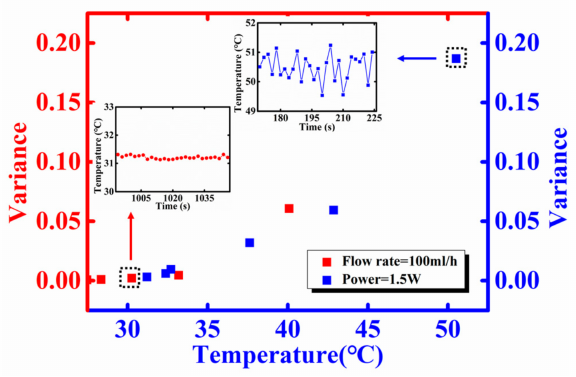
Figure 10. The variance of temperature fluctuation with the temperature change of the micro fluid by changing the power on power IC or the flow